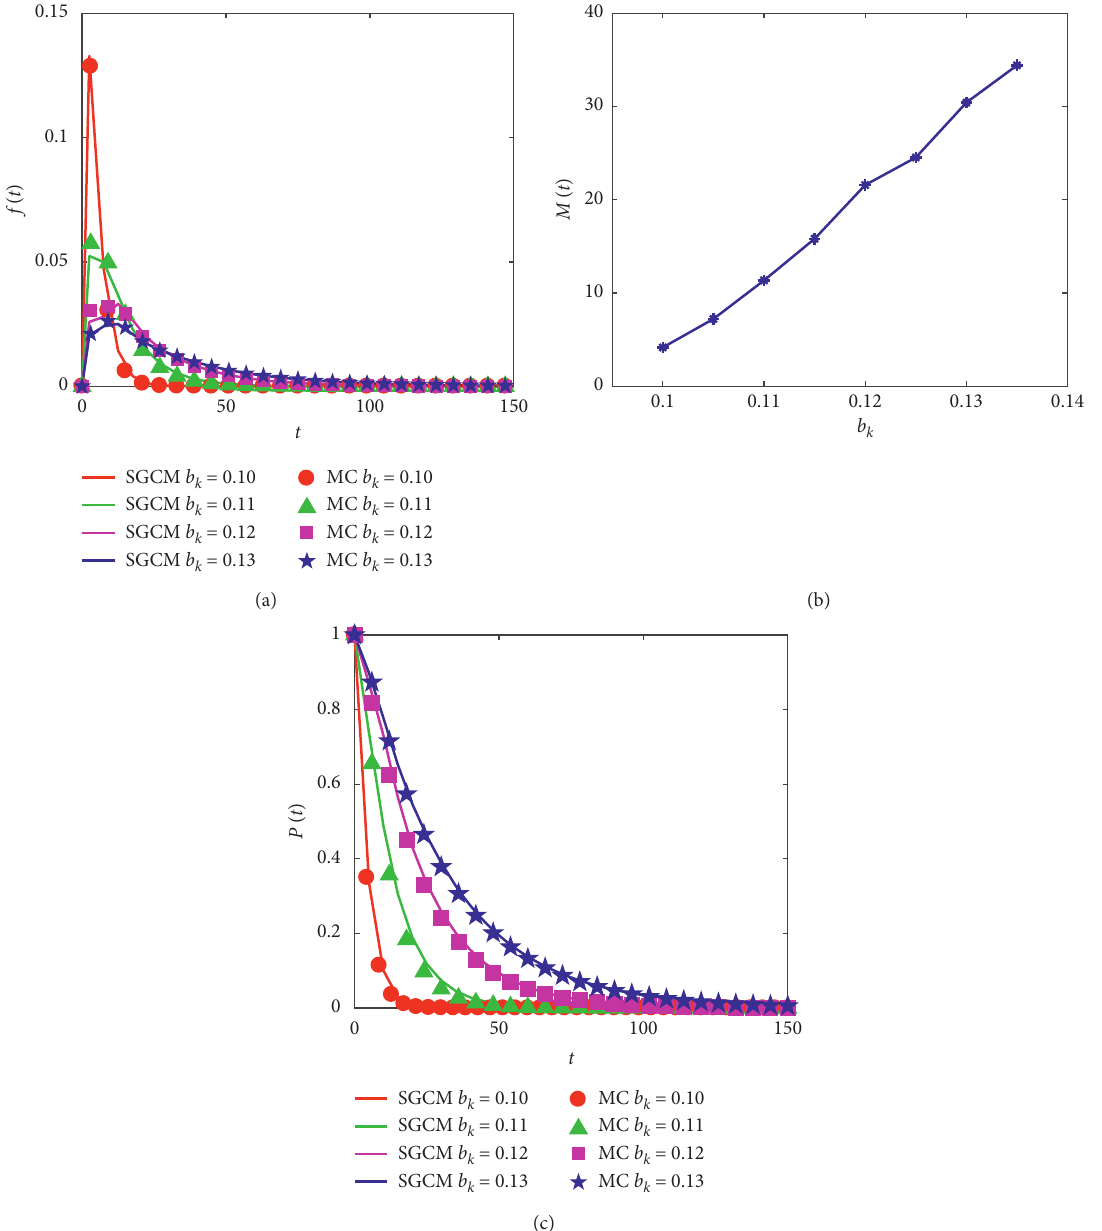
Figure 5: (a) Probability density function of FPT of system (6): D � 0 . 20, λ � 0 . 20. (b) MFPT of system (6): D � 0 . 20, λ � 0 . 20. (c) Reliability function of system (6): D � 0 . 20, λ � 0 .